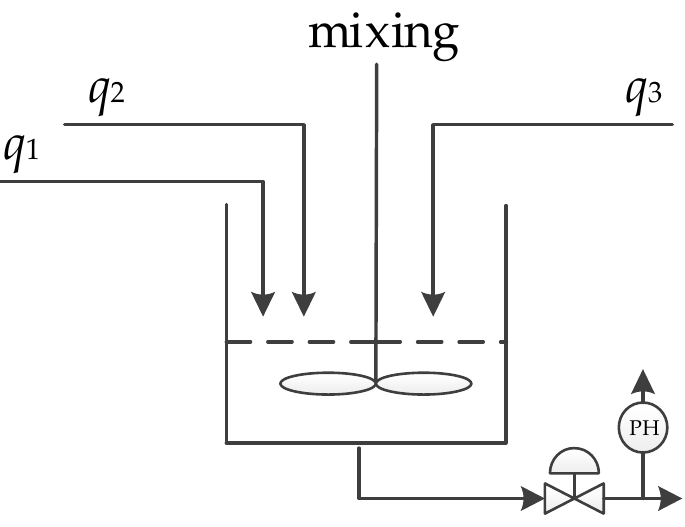
Figure 2. A schematic illustration of the process.